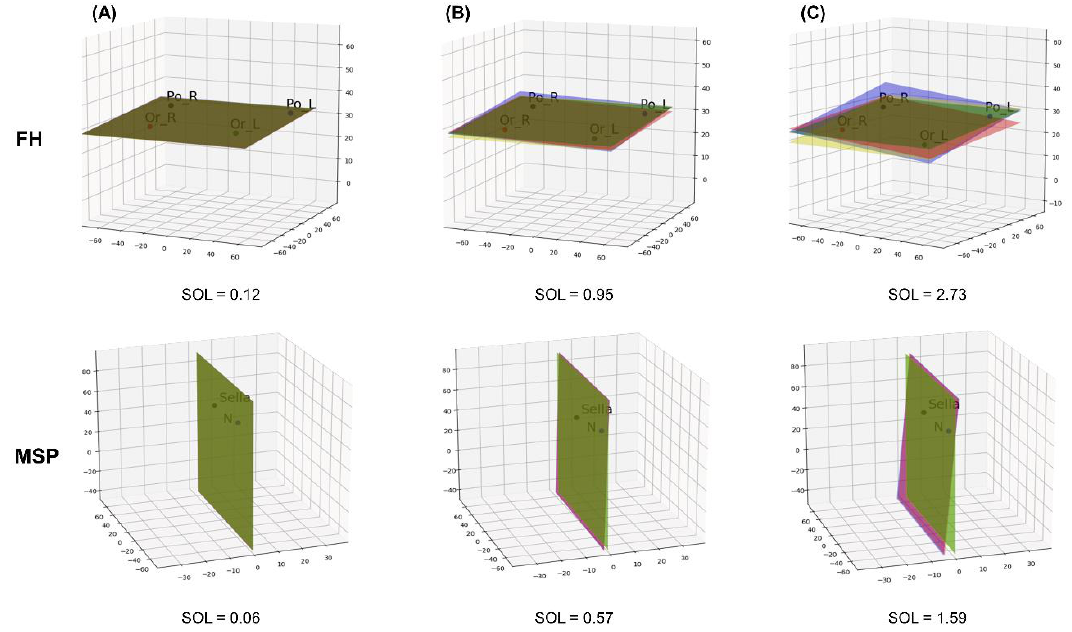
Figure 3. Comparison of the different spatial orientation levels (SOLs) of an increasing magnitude from column ( A – C ). An increase in the deviation in the Frankfort Horizontal (FH) plane results in a corresponding difference in the midsagittal plane (MSP), defined by nasion (N) and sella points. FH and MSP are color-coded to improve visualization of the differences (FH1: yellow; FH2: green; FH3: purple; FH4: pink). All numerical values are in degree angles.